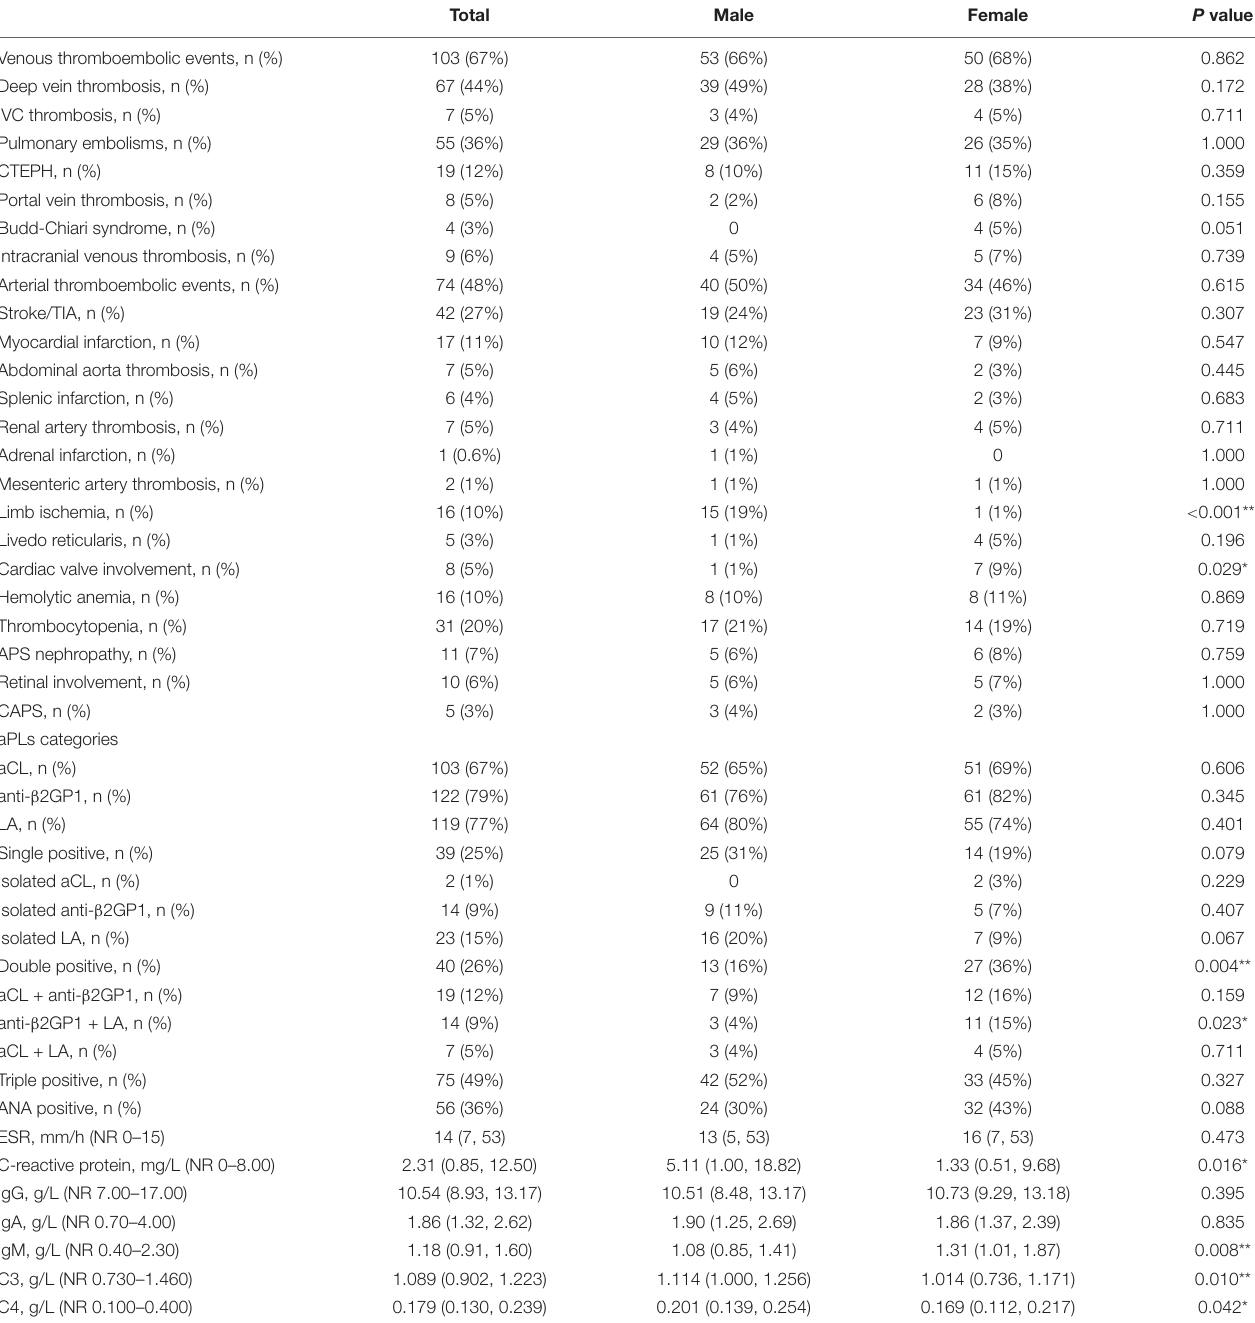
TABLE 2 | Baseline primary thrombotic antiphospholipid syndrome (ptAPS)-related events and laboratory findings. Total Male